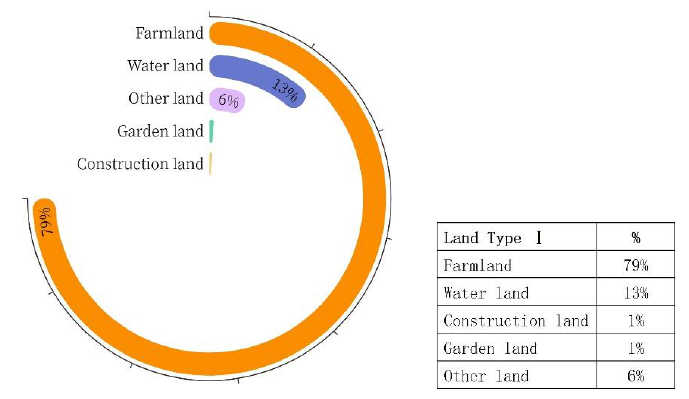
Figure 8. Chart of royal land use types.